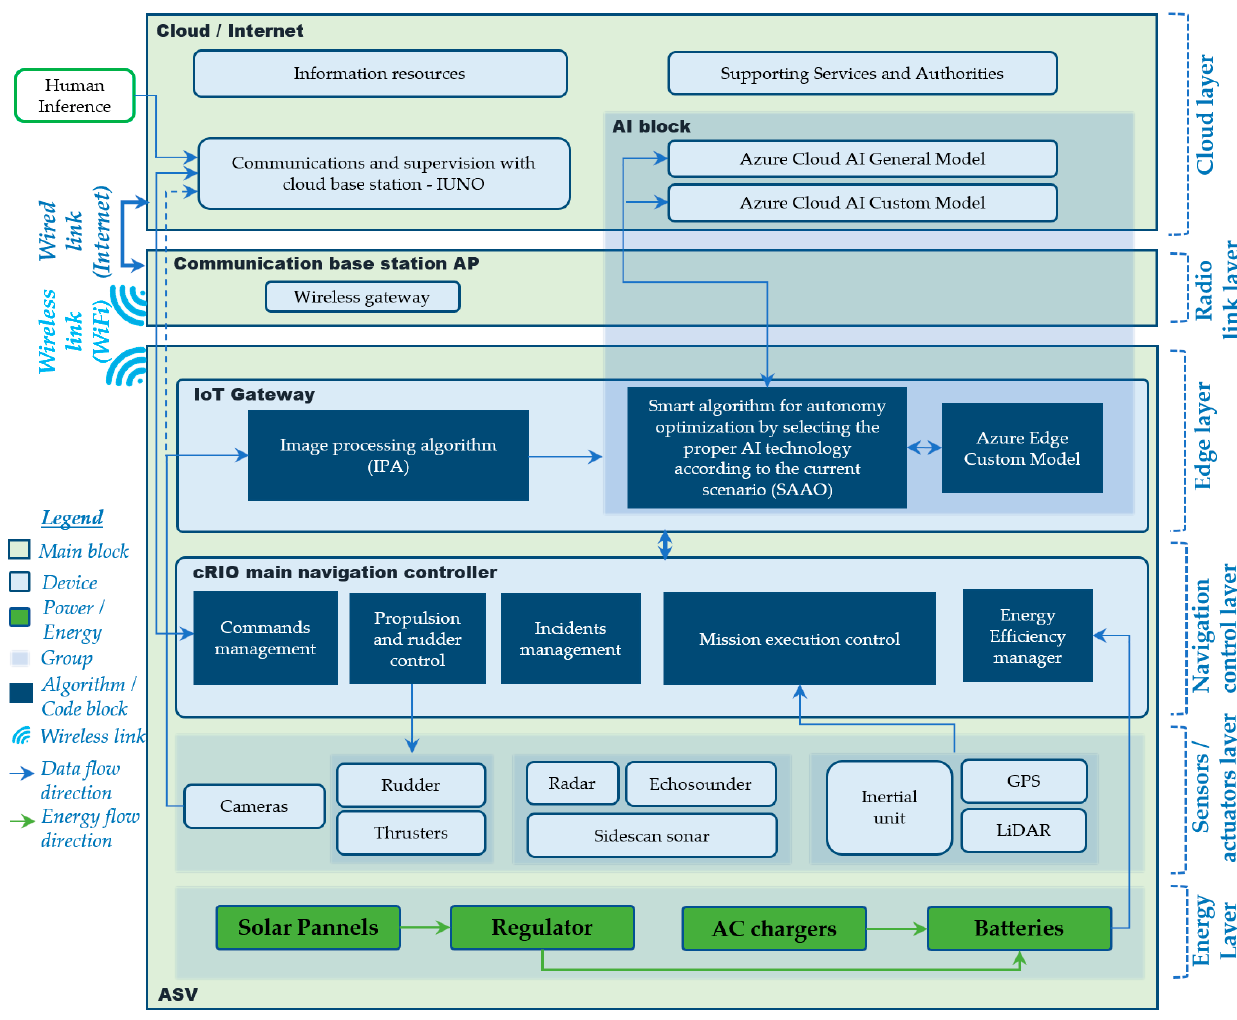
Figure 2. BUSCAMOS ‐ VIGIA framework. Figure 2. BUSCAMOS-VIGIA